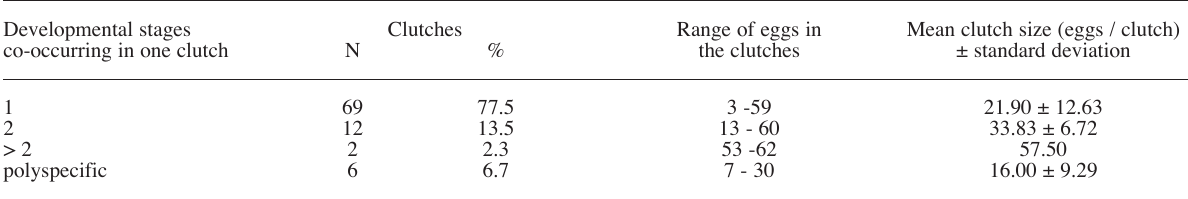
T ABLE 2. – Composition of Sepietta oweniana wild-collected egg